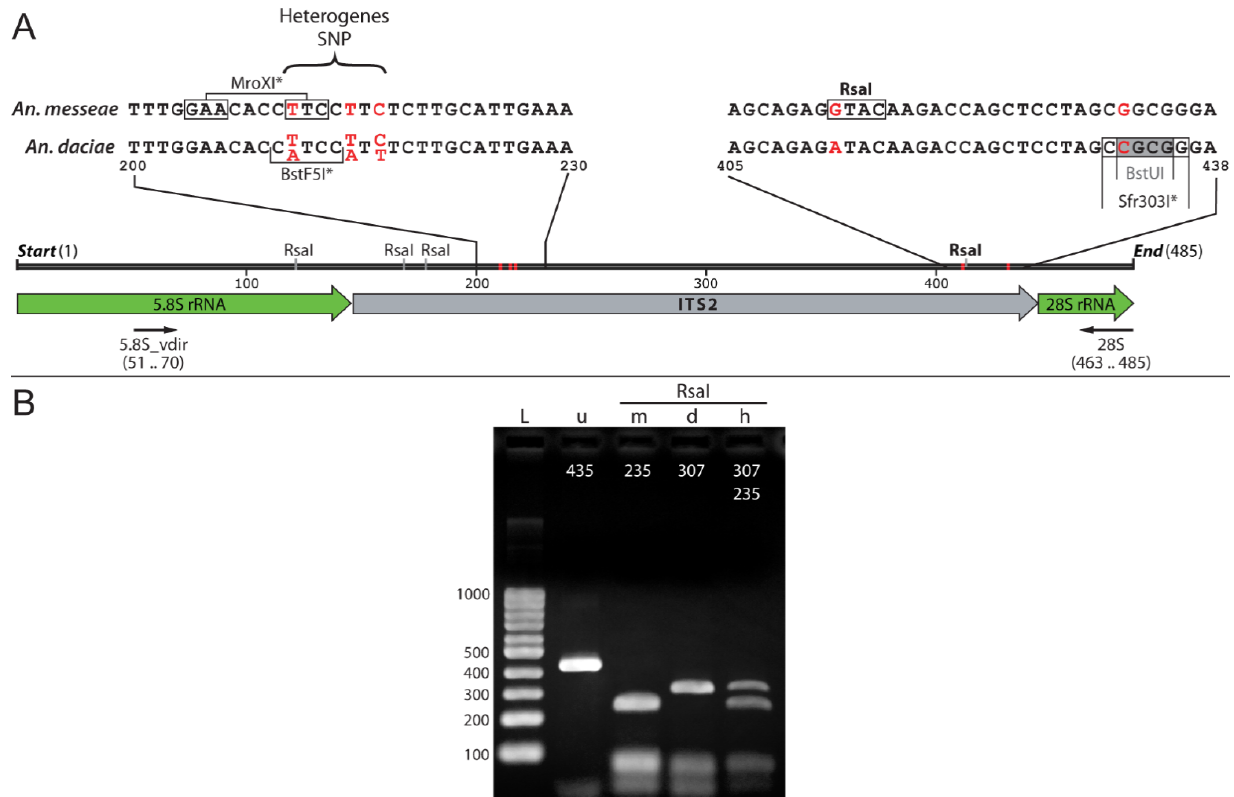
Figure 5. The ITS2-RFLP approach based on the RsaI restriction enzyme for diagnostics of An. measeae and An. daciae . Panel ( A ) represents a diagram illustrating the structure of ITS2 in An. messeae and An. daciae and its restriction by enzyme RsaI. Letters on the top indicate sequences of SNP regions and sites for restriction enzymes RsaI, MroXI, BstF5I, BstUI and Sfr303I that were used in different studies for species identification. The structure of ITS2 is shown based on coordinates according to the AY648982 sequence [17] . The positions of five nucleotides that differentiate species are shown by red letters or red stripes. Unique restriction sites are marked by an asterisk. The RsaI restriction site, which was utilized for species diagnostics in this study, is shown in bold. Positions of primers used for PCR amplification are shown by black arrows. Panel ( B ) shows a pattern of ITS2-RFLP restriction by RsaI of PCR products obtained from An. messeae (m), An. daciae (d), and their hybrid (h). Undigested PCR-product (u) is shown next to the DNA ladder (L).